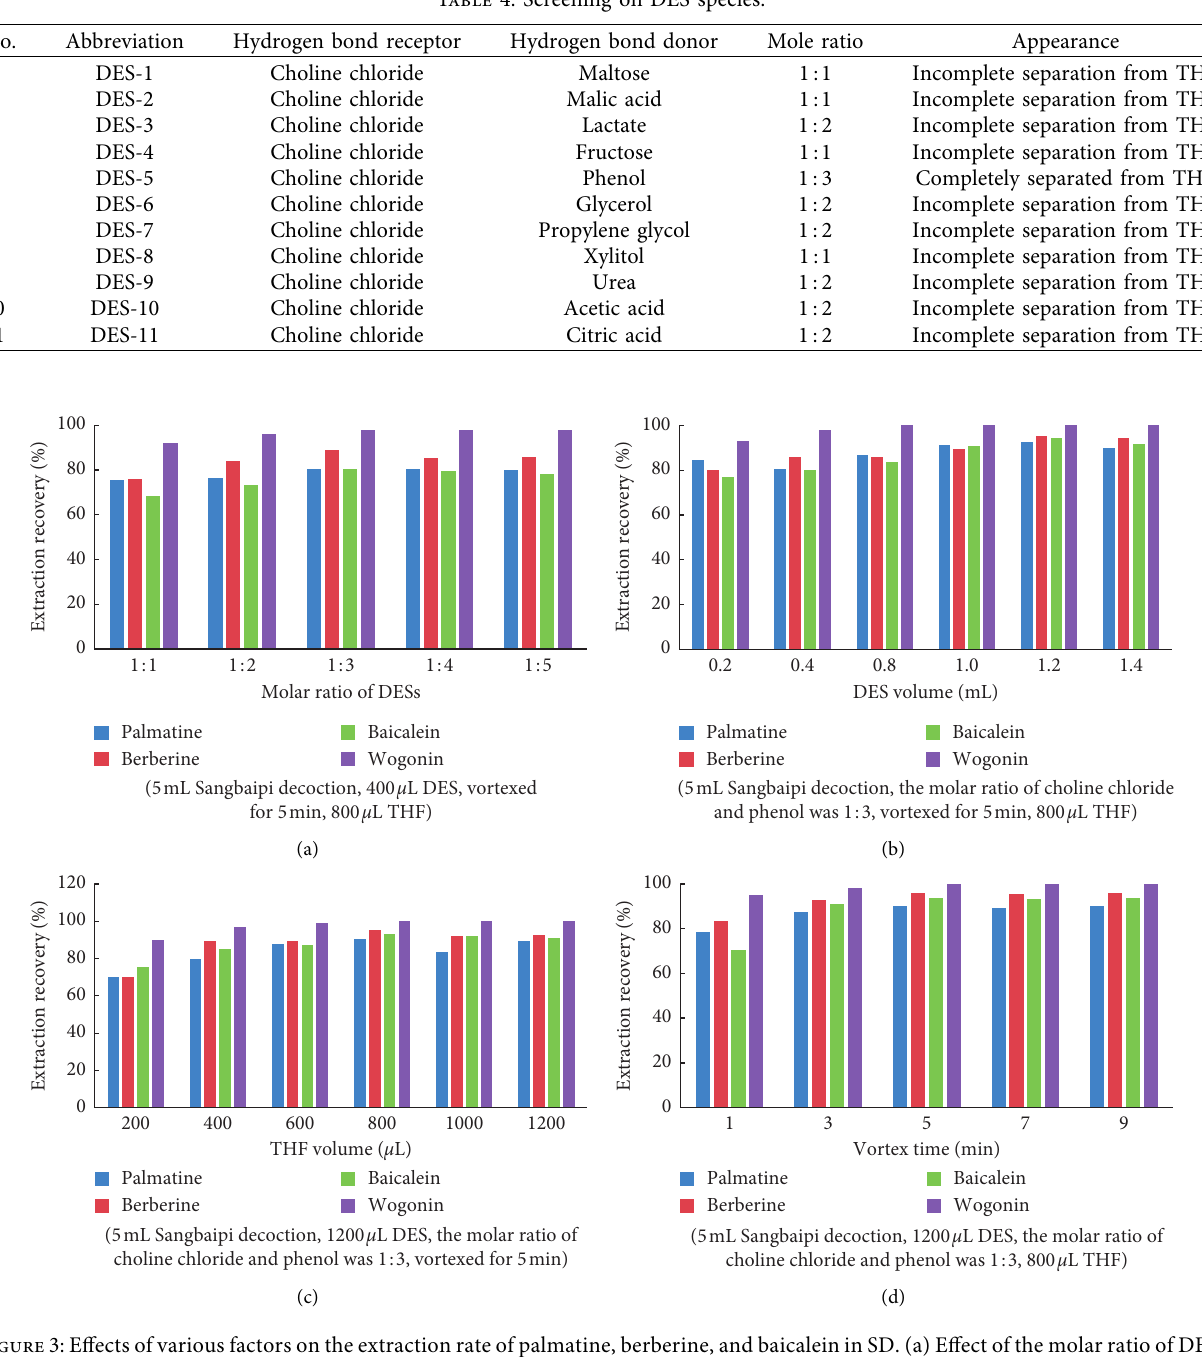
Table 4: Screening on DES species.